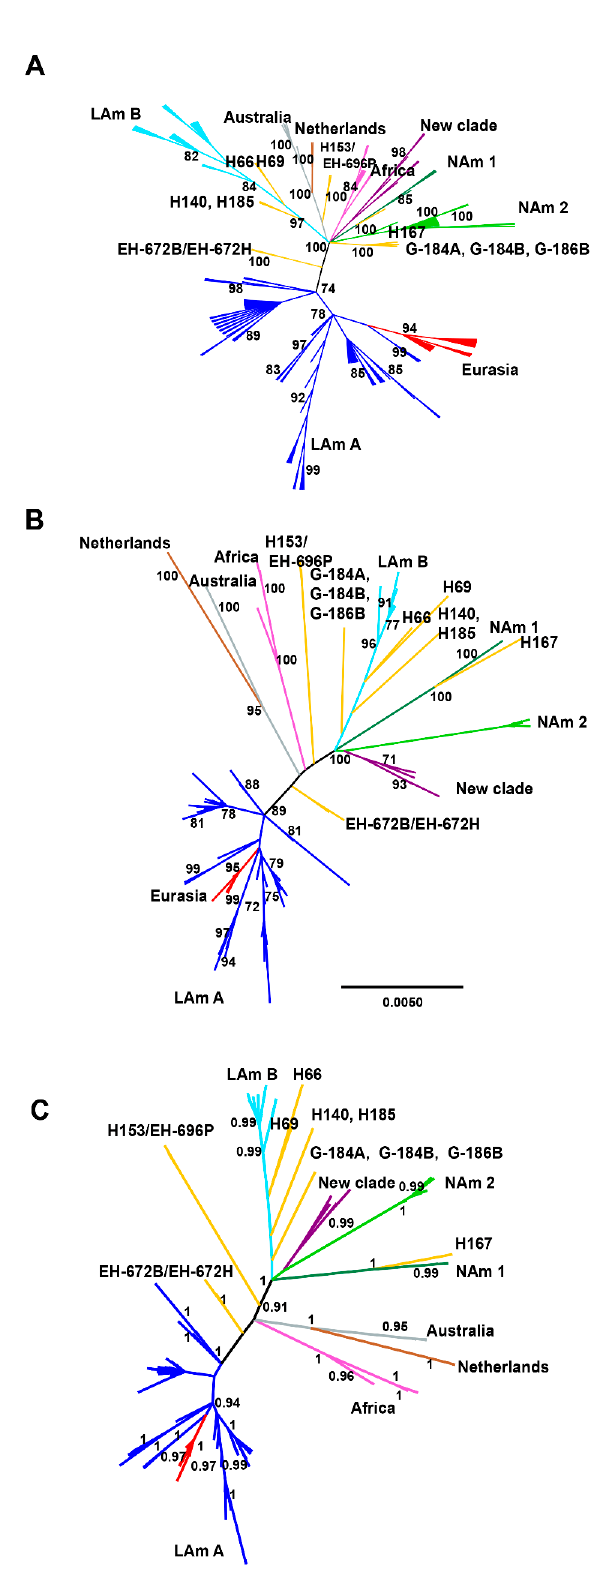
Figure 1. Unrooted phylogenetic trees of H. capsulatum isolates generated by different inference methods. The analyses were performed with a concatenated matrix of 1538-nt constructed with four gene fragments ( arf , H-anti , ole1 , and tub1 ). ( A ) Parsimony strict consensus tree with a bt ≥ 70%; ( B ) maximum likelihood tree with a bt ≥ 70%; ( C ) Bayesian inference maximum clade credibility tree was selected with a pp limit of 0.95. The support values of bt and pp are indicated on their corresponding tree nodes (details under Materials and